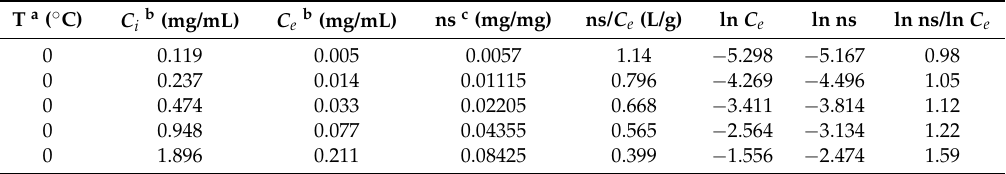
Table 2. Parameters of adsorption isotherms.